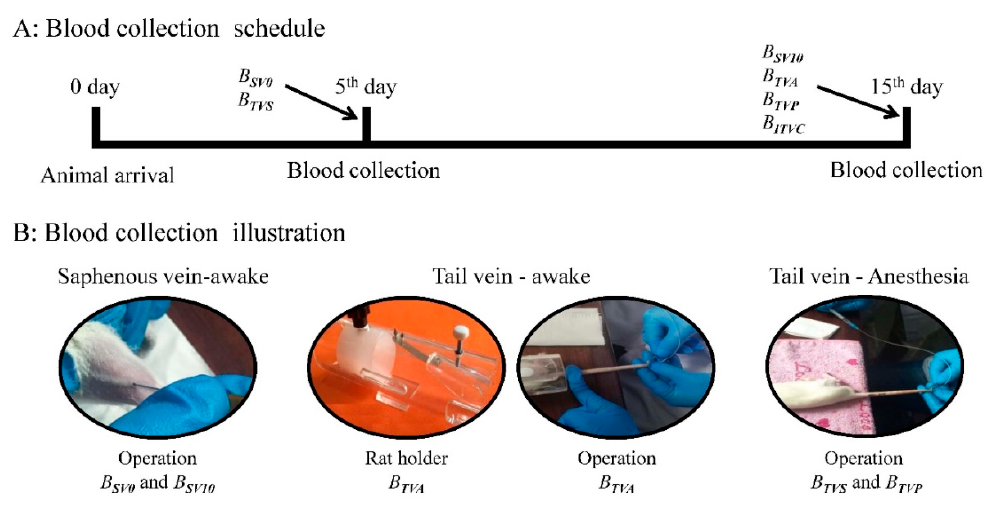
Figure 1. Flow chart of the whole experimental procedure ( A ) and demonstrations of the blood collection from the saphenous vein and the tail vein under awake/anesthesia states ( B ). Note: B: blood; SV0 or SV10: Blood collection from the saphenous vein after 0th or 10th day. TVA, TVS or TVP: Blood collection from the tail vein under awake or anesthesia state induced by sevoflurane or pentobarbital; ITVC: Blood collection from the inferior thoracic vena cava.